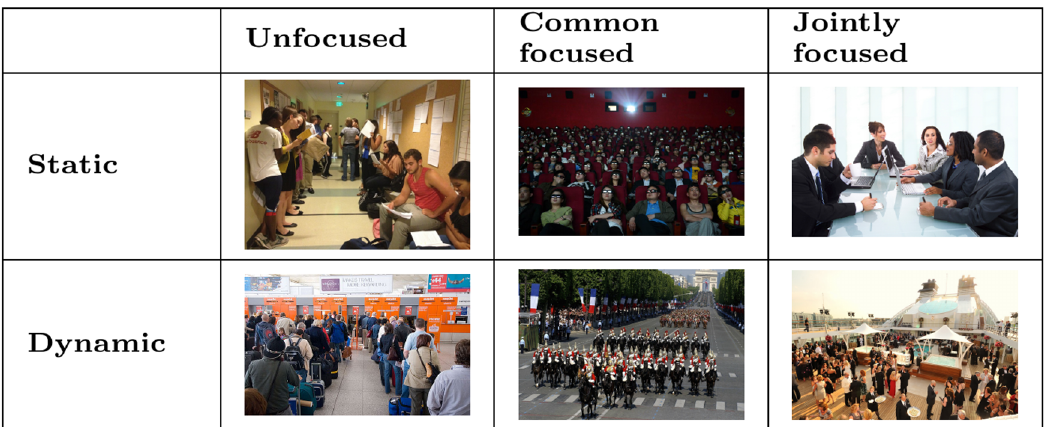
Fig 3. Examples of gatherings categorised by focus of attention and spatio-proxemic freedom. Jointly focused, dynamic: our case, FCGs at a cocktail party; common focused, dynamic: a parading platoon; unfocused, dynamic: a queue at the airport; jointly focused, static: a meeting; common focused, static: people in a theatre stand; unfocused, static: persons in a waiting